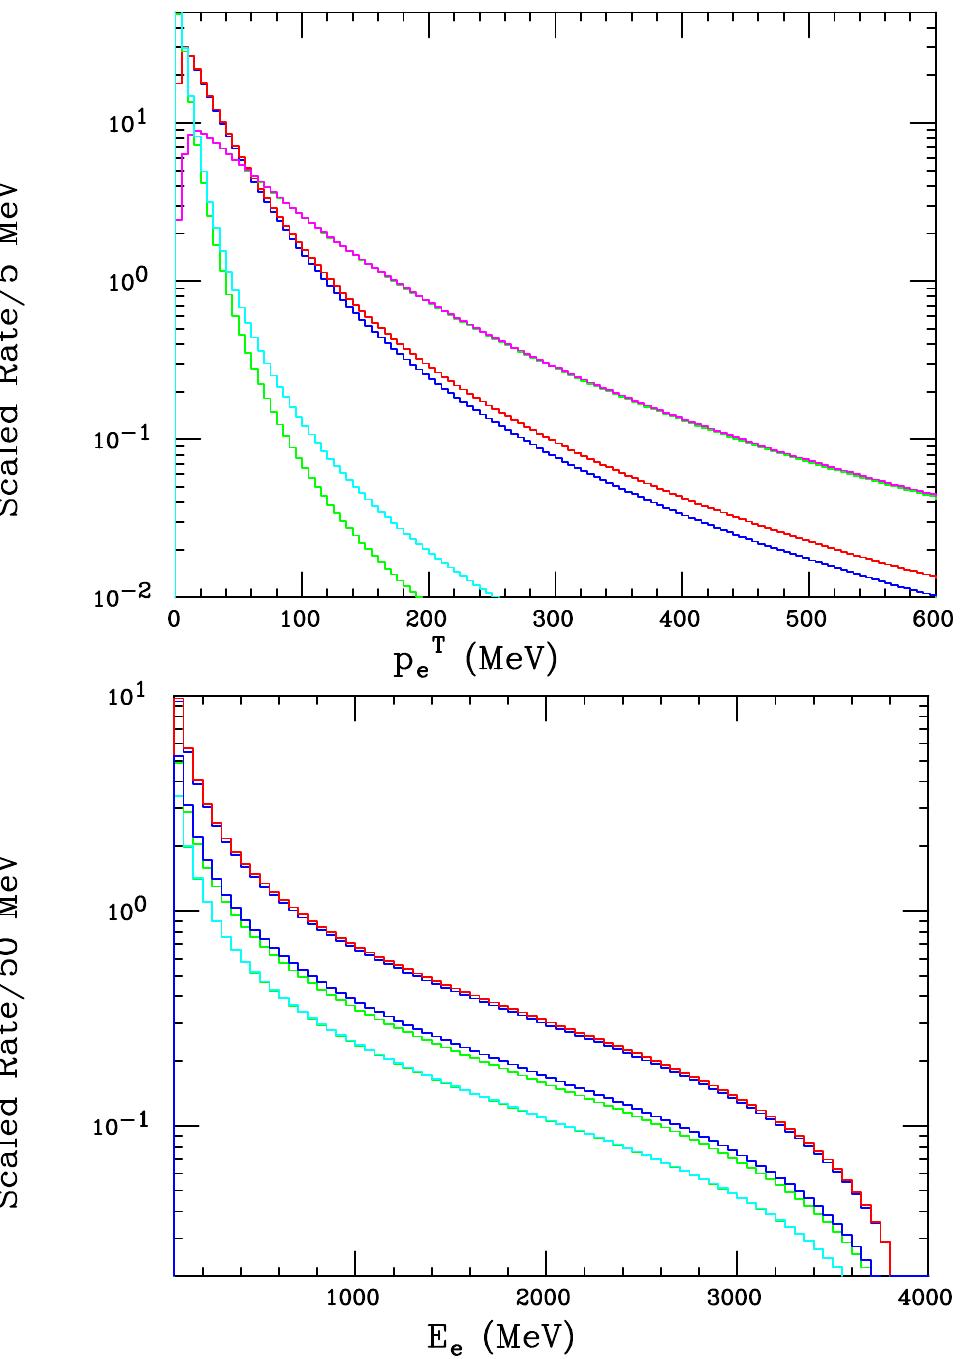
Figure 6 . Comparison 4-D and 5-D model predictions for the electron p T (top) and recoil energy (bottom) distributions at LDMX. In the upper panel in the center of the plot the histograms are, from top to bottom, for R (cid:0) 1 = 500, 200 and 50 MeV, respectively. In the lower panel, in the center of the plot the histograms are, from top to bottom, are for R (cid:0) 1 = 200, 50 and 500 MeV, respectively. Note that pair-to-pair normalizations are arbitrary.